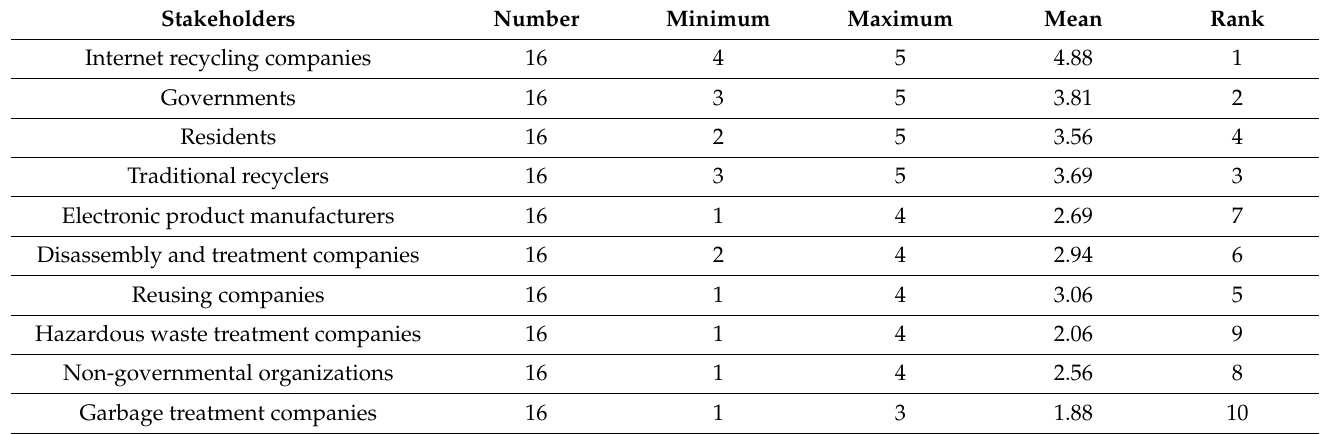
Table 4. WEEE internet recycling industry stakeholder initiative scores.